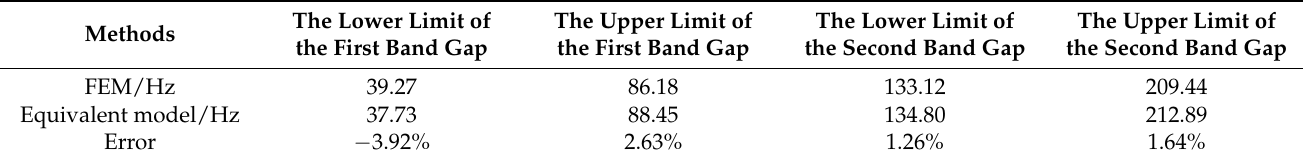
Table 2. The results of FEM and equivalent model